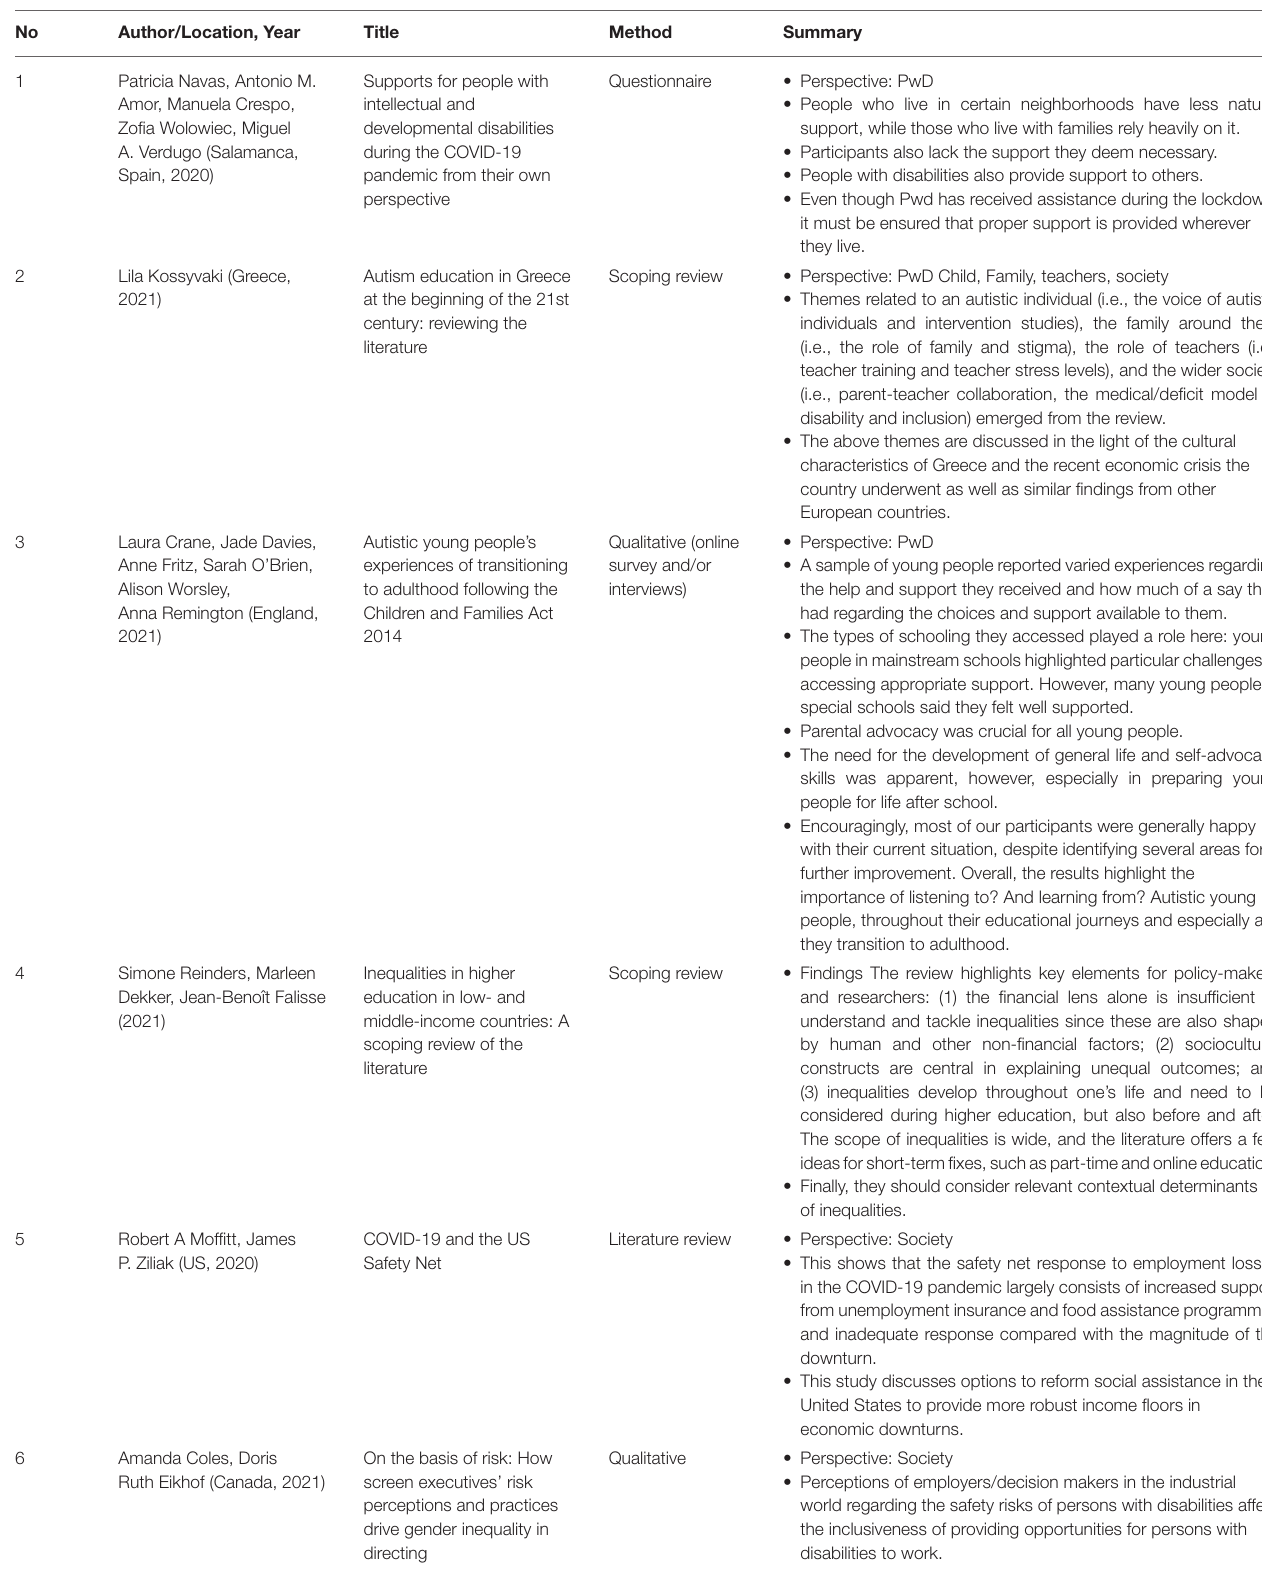
TABLE 1 | Summary of literature